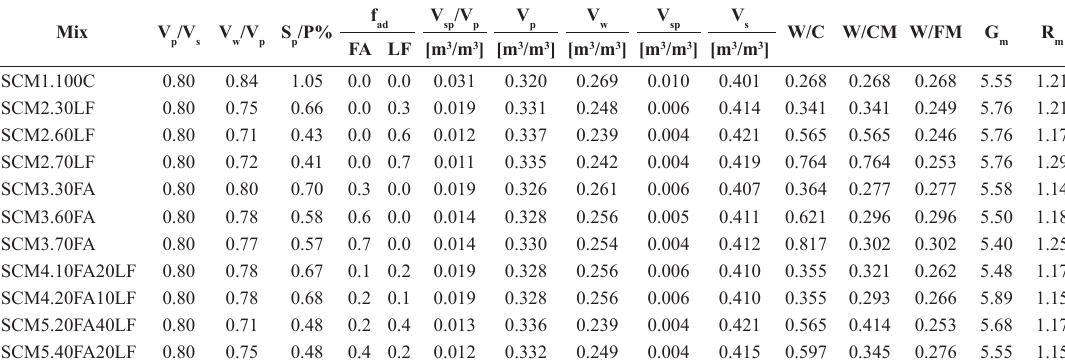
f = percentage of replacement of cement with additions; V ad absolute volume (cement and mineral admixtures); V